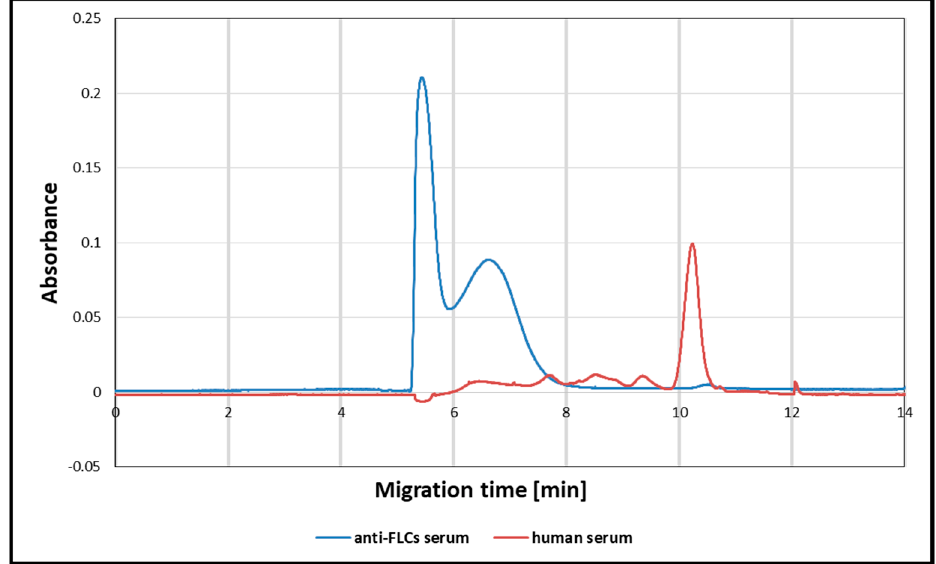
Figure 5. Capillary electropherogram of the anti-FLCs serum (blue line) and human serum, as a reference (red line).